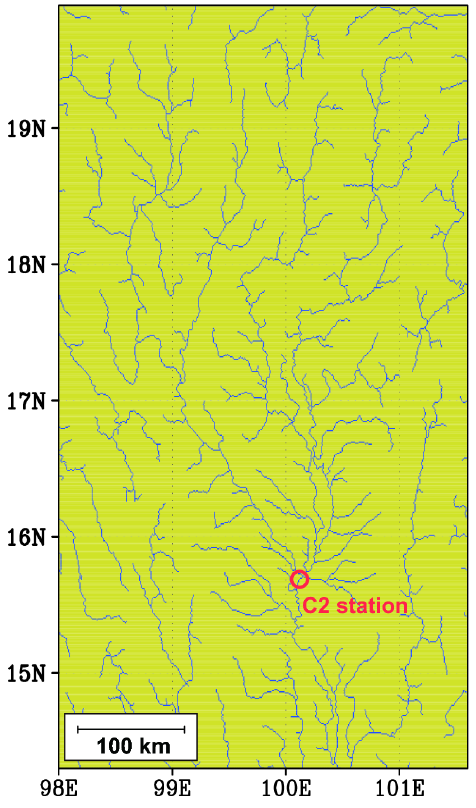
Figure 1. River channel structure in the Chao Phraya river basin. The flow in the blue-colored grid is regarded as channel flow. Oth- erwise, a slope flow is considered. The red circle shows the C2 river discharge